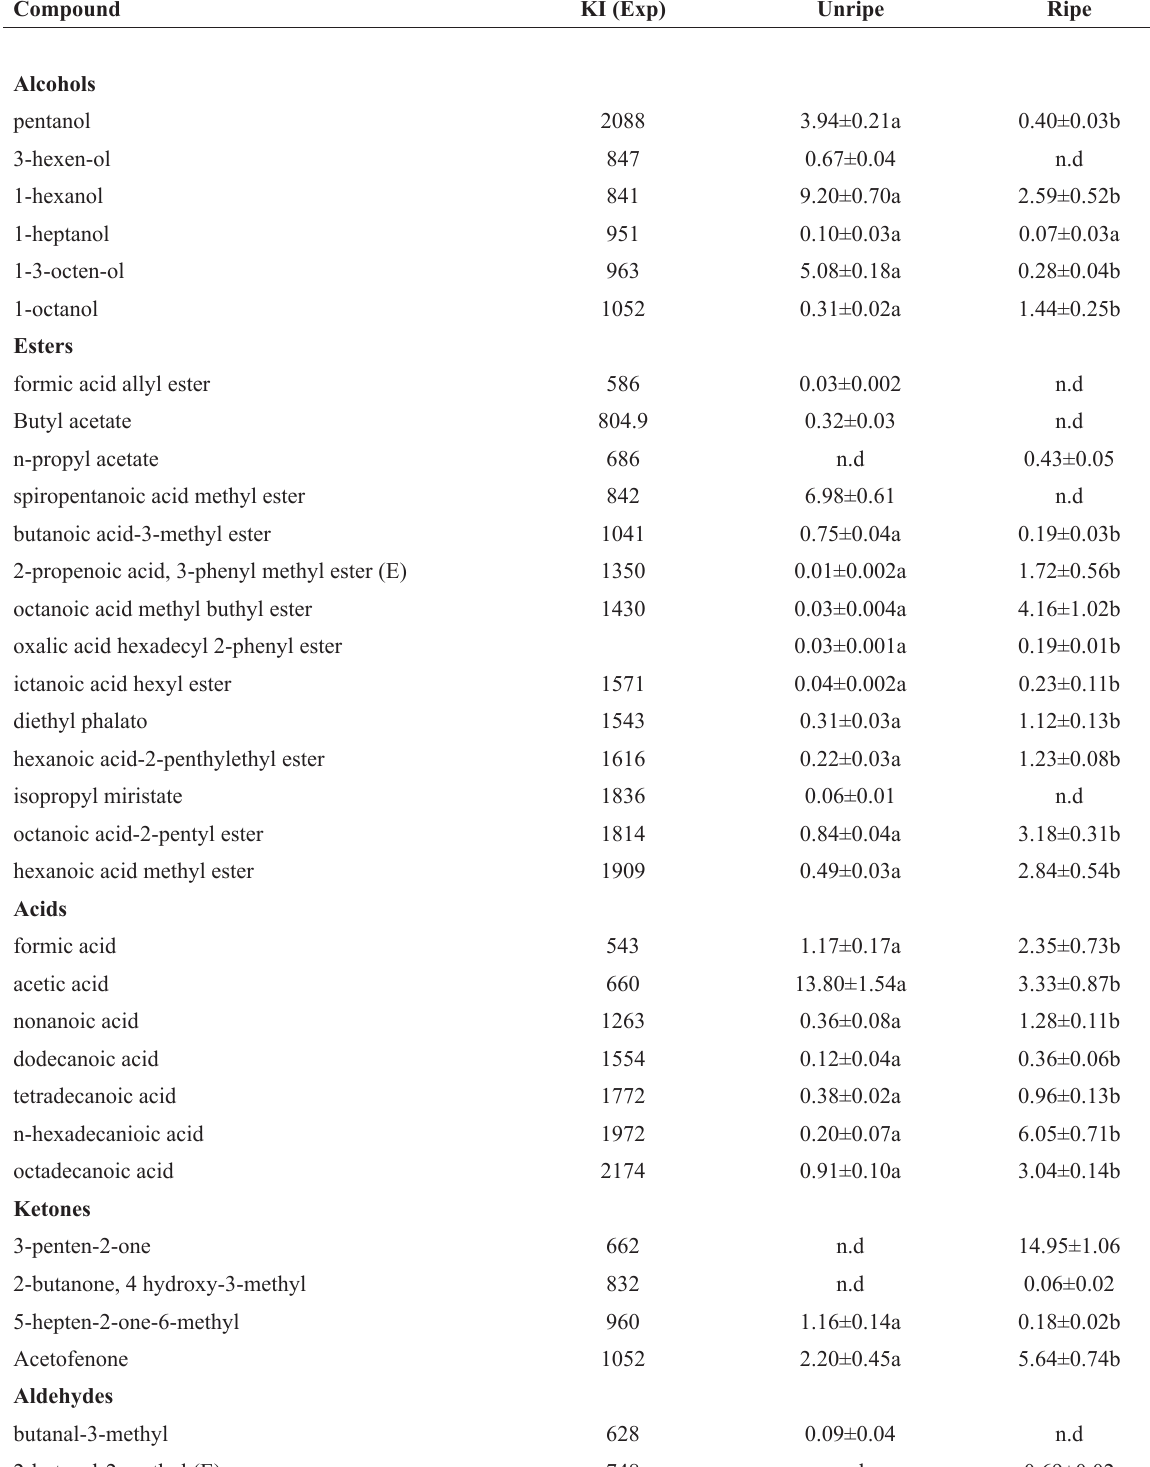
Volatile fraction composition in two maturation stages of ackee fruits (expressed as peak area